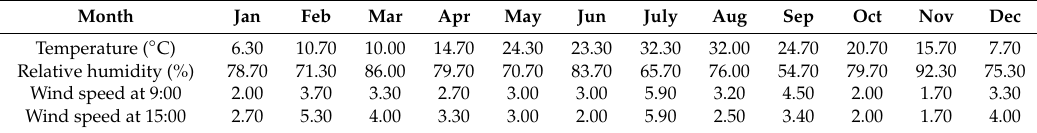
Table 1. The meteorological parameters during the sampling periods by month at